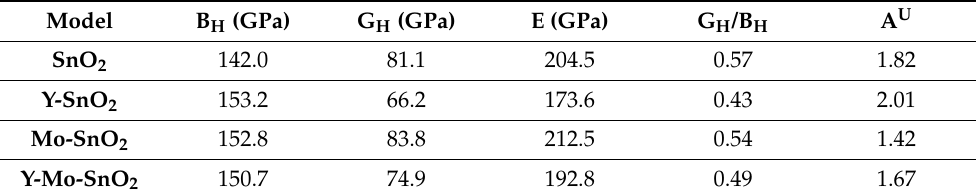
Table 6. Bulk modulus, shear modulus, Young’s modulus, microhardness and universal elastic anisotropy index.